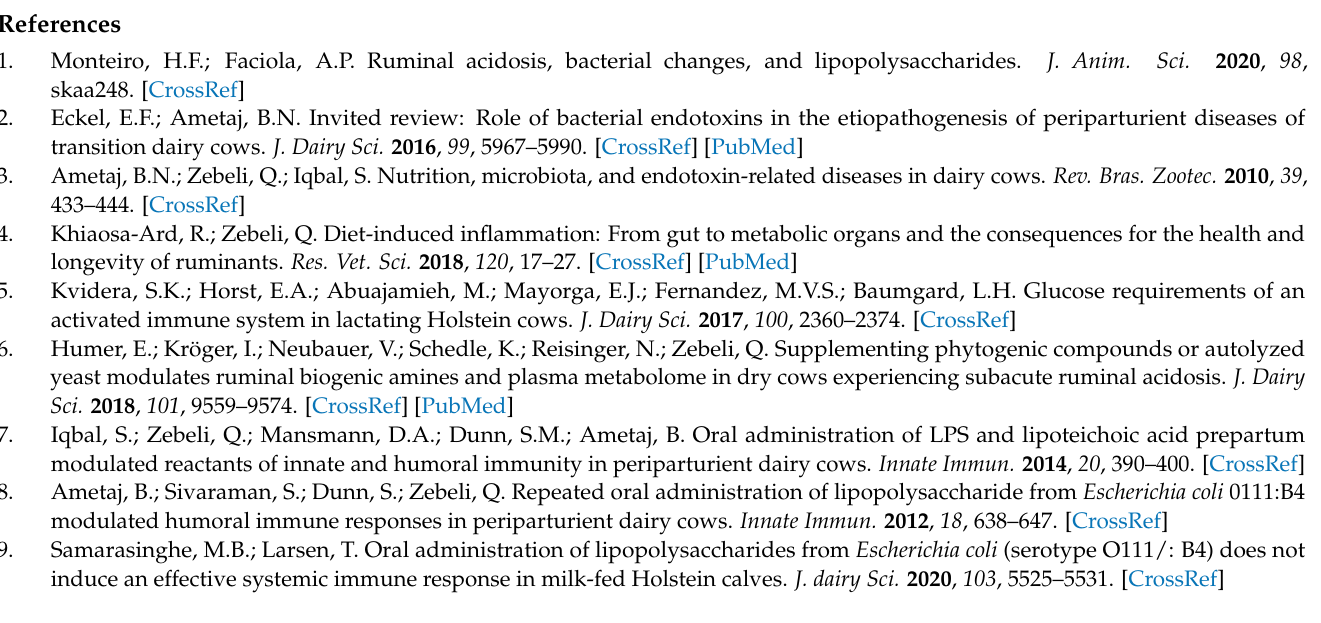
Figure S1. Absorbance values at 450 nm measured with the WST-1 assay of control explants after 24 h of incubation with medium. Error bars display the standard deviation. Figure S2. PCA plots of the expression of all measured genes of explants before incubation (Start), untreated explants (Control) after 4 h of incubation, and ex-plants incubated with 1, 5, and 10 µ g/mL LPS (LPS1, LPS5, LPS10) for 4 h. n = 5